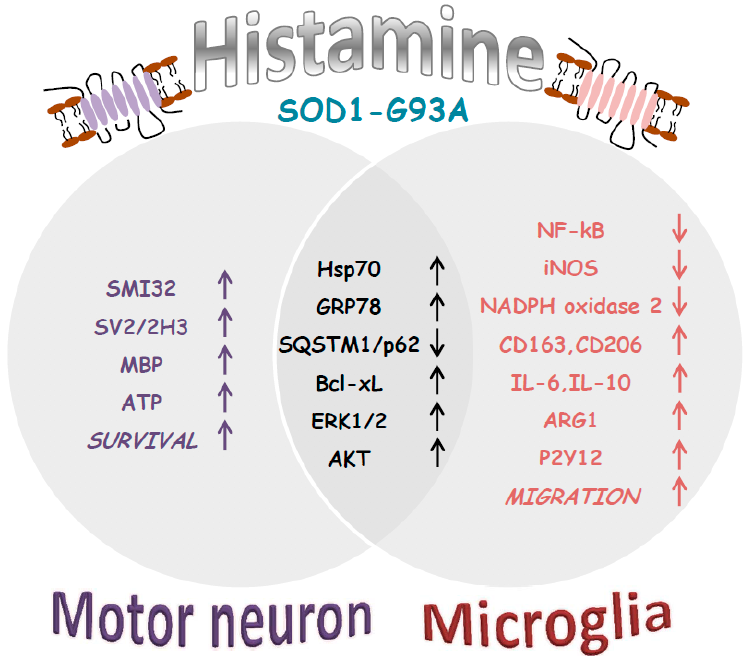
Figure 5. Synopsis of histamine effects on ALS disease features. In SOD1-G93A motor neurons, histamine increases mitochondrial functionality (ATP content) and survival (SMI32), also protecting axons (SV2/2H3; MBP) [16]. In SOD1-G93A microglia, histamine decreases pro-inflammatory markers (NF-kB, iNOS and NADPH oxidase 2), and increases anti-inflammatory markers (CD163, CD206, IL-6, IL-10 ARG1, P2Y12) together with cell migration [17]. In both motor neurons and microglia histamine activates AKT/ERK1/2 [16,17] in addition to Hsps (GRP78, Hsp70) and Bcl-xL responses, while decreasing SQSTM1/p62 (Figures 1–4).